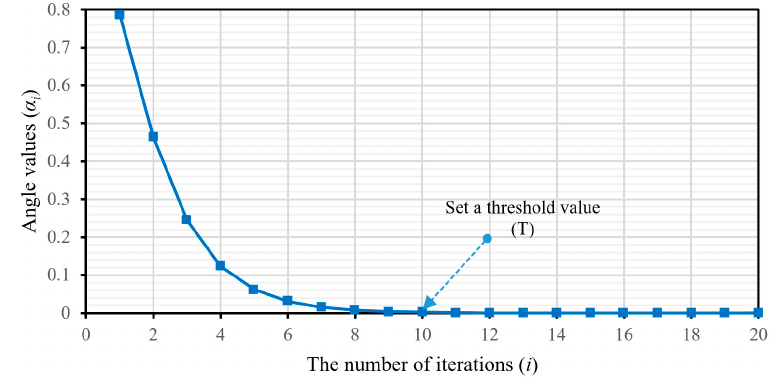
Figure 4. Evaluating the change of rotation angle by the number of iterations.